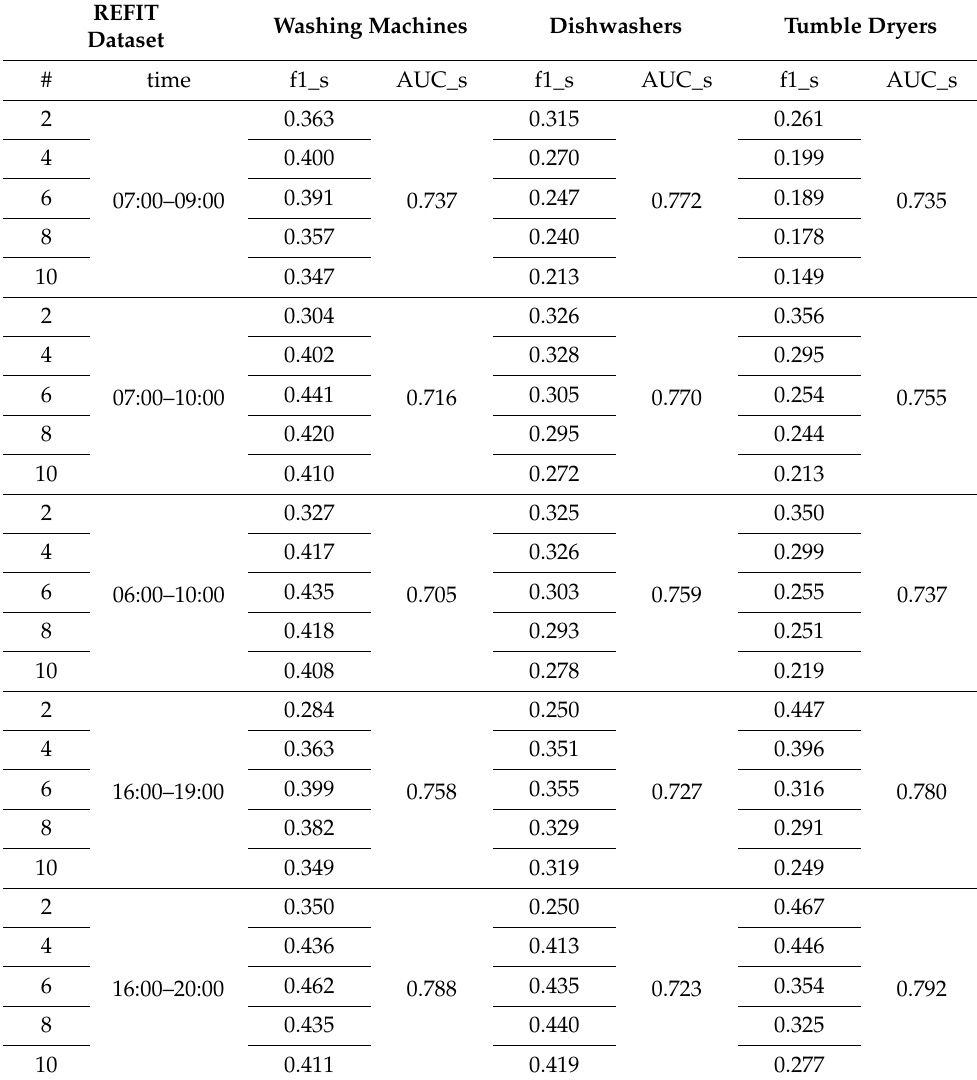
Table 5. Different peak periods-single